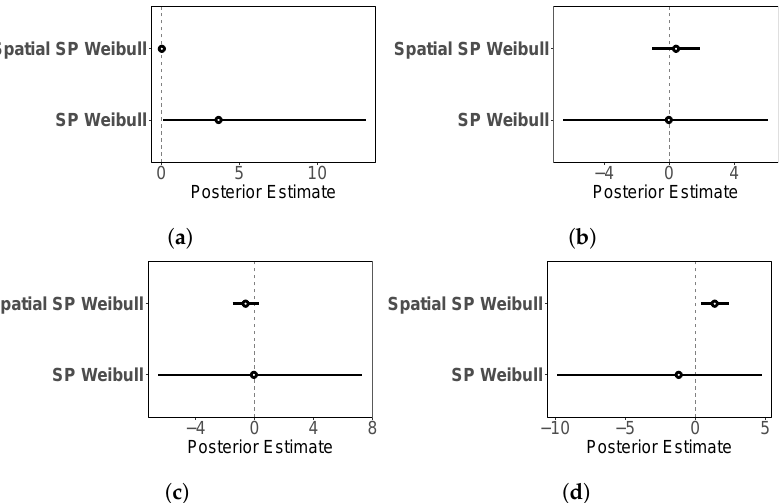
Figure 8. Peace consolidation ( ˆ γ ) coefficient results from SP Weibull and Spatial SP Weibull models for the following covariates: ( a ) press freedom, ( b ) victory, ( c ) mountains, and ( d )